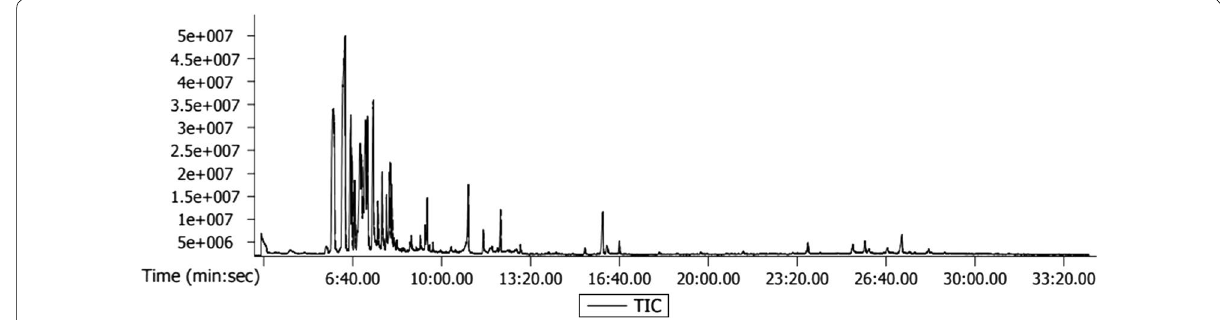
Fig. 1 GC–MS chromatogram of bioactive compounds in guava leaf